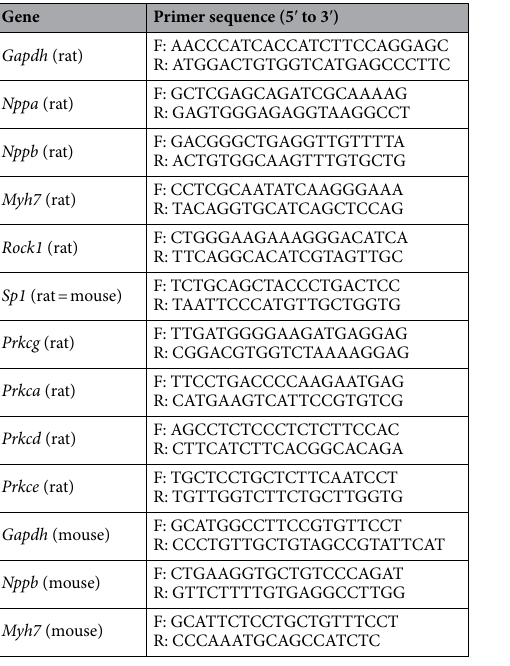
Table 1. Primers for